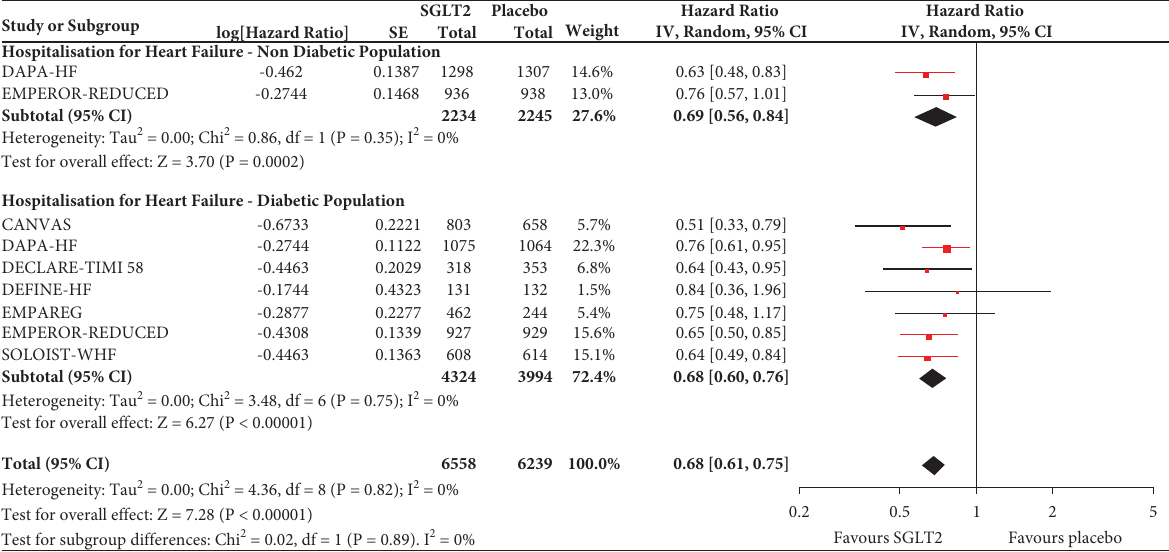
Figure 5: Subgroup analysis of the treatment effect SGLT2 inhibitors on hospitalisation for heart failure depending on baseline diabetes status.